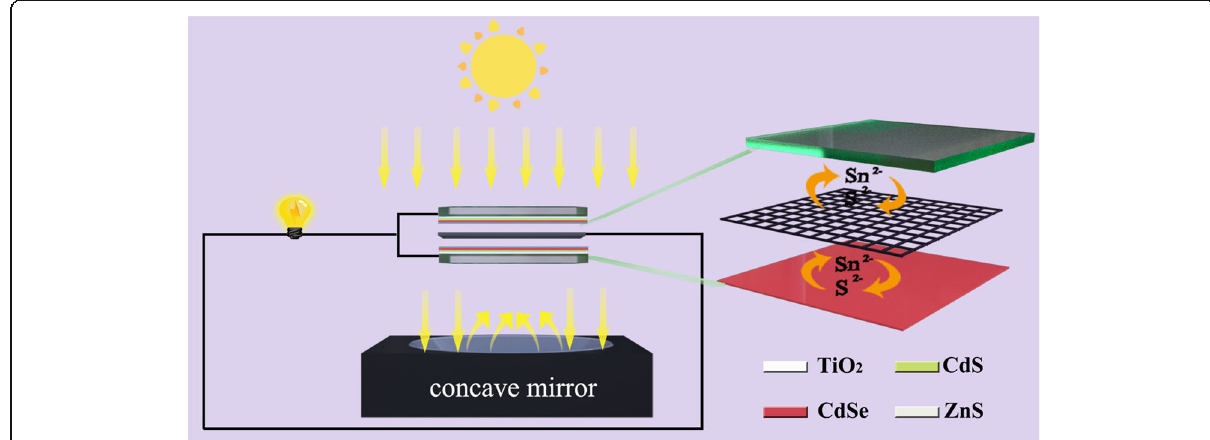
Fig. 1 Schematic diagram of the cell design in the present